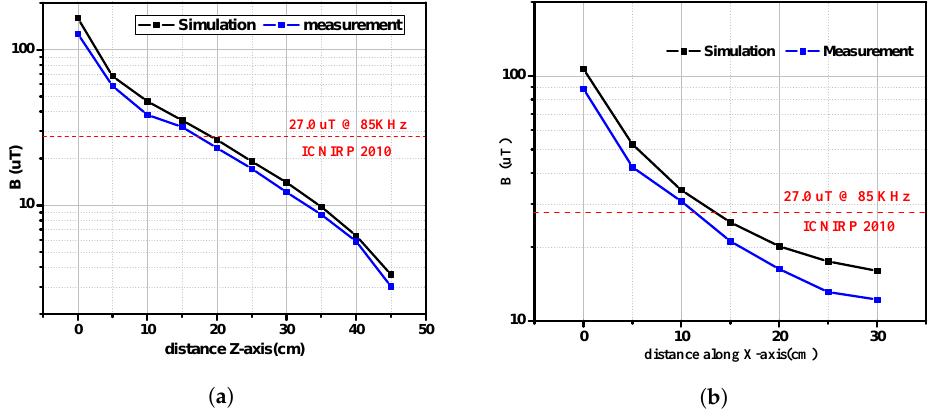
Figure 20. Measurement, and simulation of magnetic flux density ( a ) in the Z -axis direction above the Rx Pad; ( b ) in the X-axis direction from the edge of the Rx